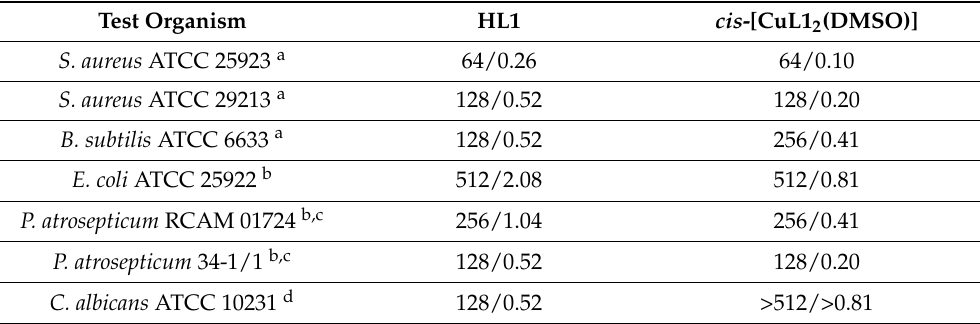
Table 1. Minimum inhibitory concentration ( µ g · mL − 1 /mM) determined for the test compounds. Test Organism HL1 cis -[CuL1 2